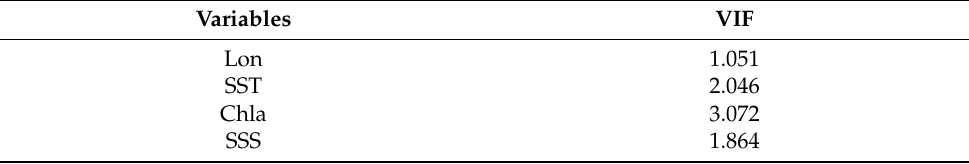
Table 2. Collinearity analysis based on VIF.